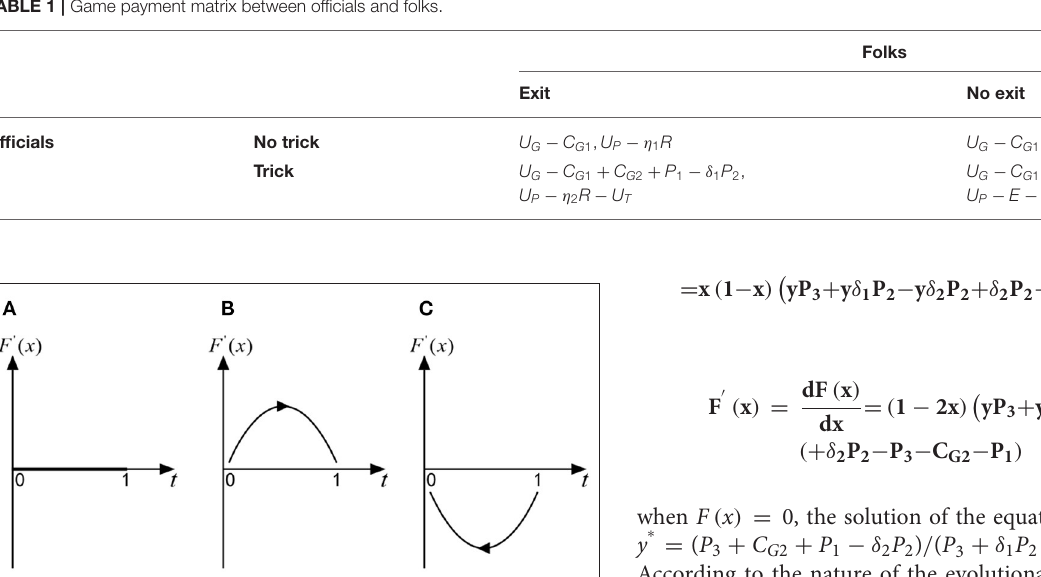
TABLE 1 | Game payment matrix between officials and folks.